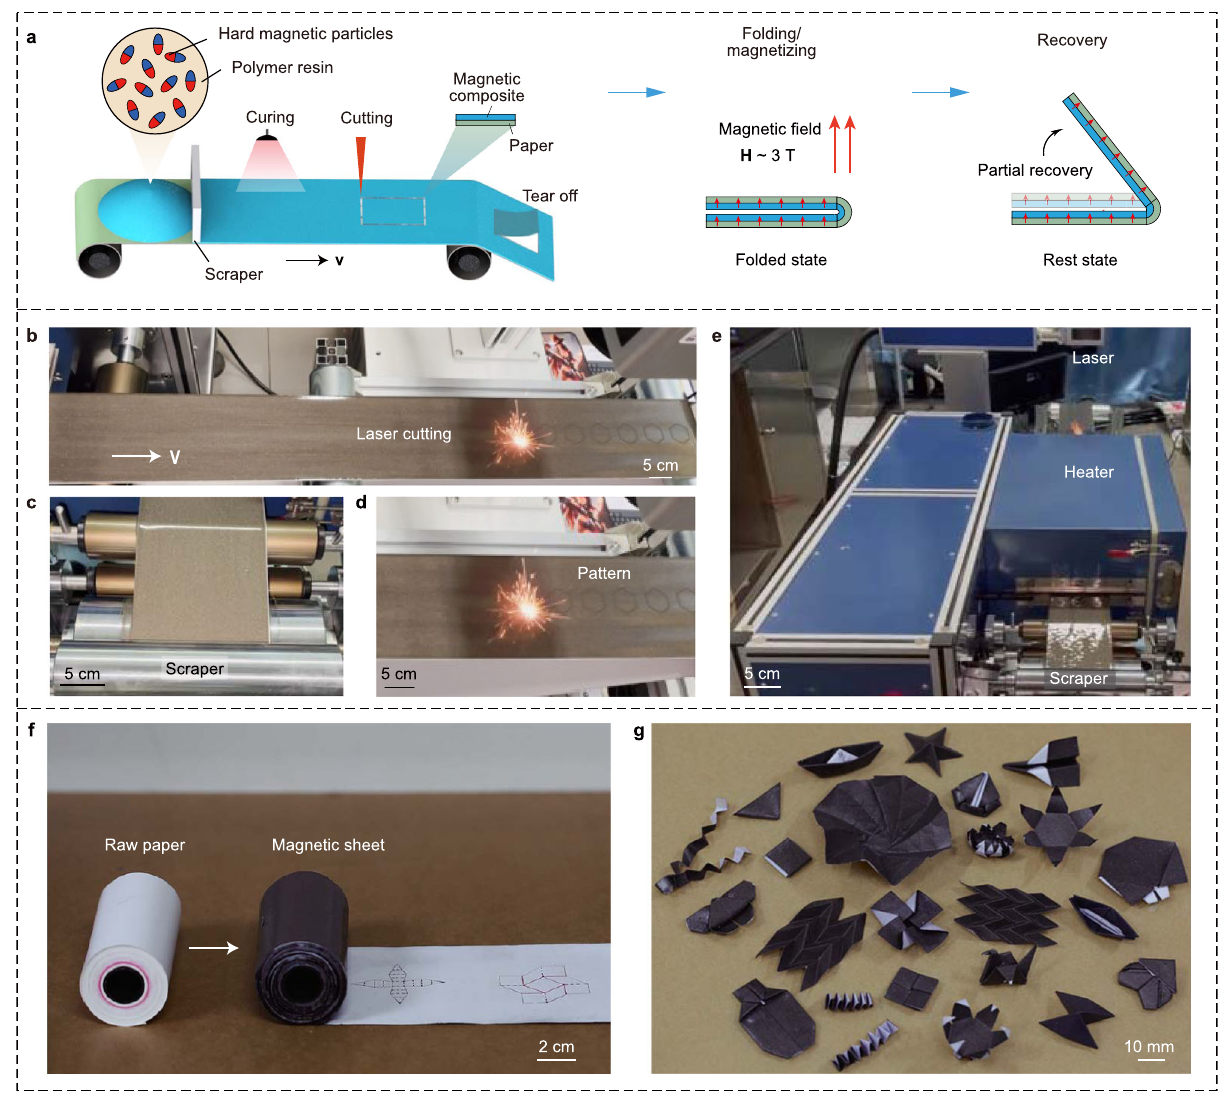
Fig. 1 Fabrication of magneto-origami machines. a Schematic illustration of fabrication processes of the patterned magnetic sheet by roll-to-roll method, folding/magnetizing, and partial recovery. b – e Experimental pictures of ( b ) laser cutting, ( c ) scraper, ( d ) pattern, and ( e ) curing heater of the roll-to-roll platform to fabricate patterned magnetic sheets. f Images showing a roll of raw paper and a magnetic sheet with a 2D origami pattern. g